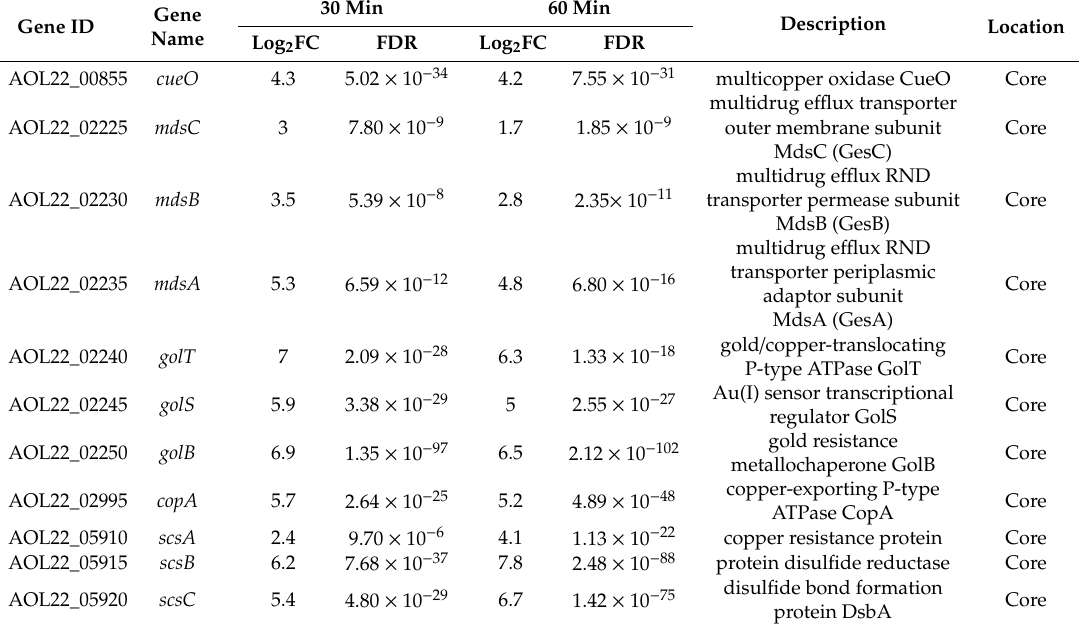
Figure 2. Di ff erential expression of serovar I 4,[5],12:i:- genes following exposure to 5 mM copper sulfate. Strain SX 240 gene expression in the presence and absence of 5 mM CuSO 4 after 30 and 60 min of exposure. Principal component analysis of the variation in gene expression +/ − Cu exposure ( A ) and a Venn diagram of the number of unique or common genes di ff erentially expressed ( B ). Table 2. Di ff erential gene expression of serovar I 4,[5],12:i:- metal tolerance genes in response to copper exposure.